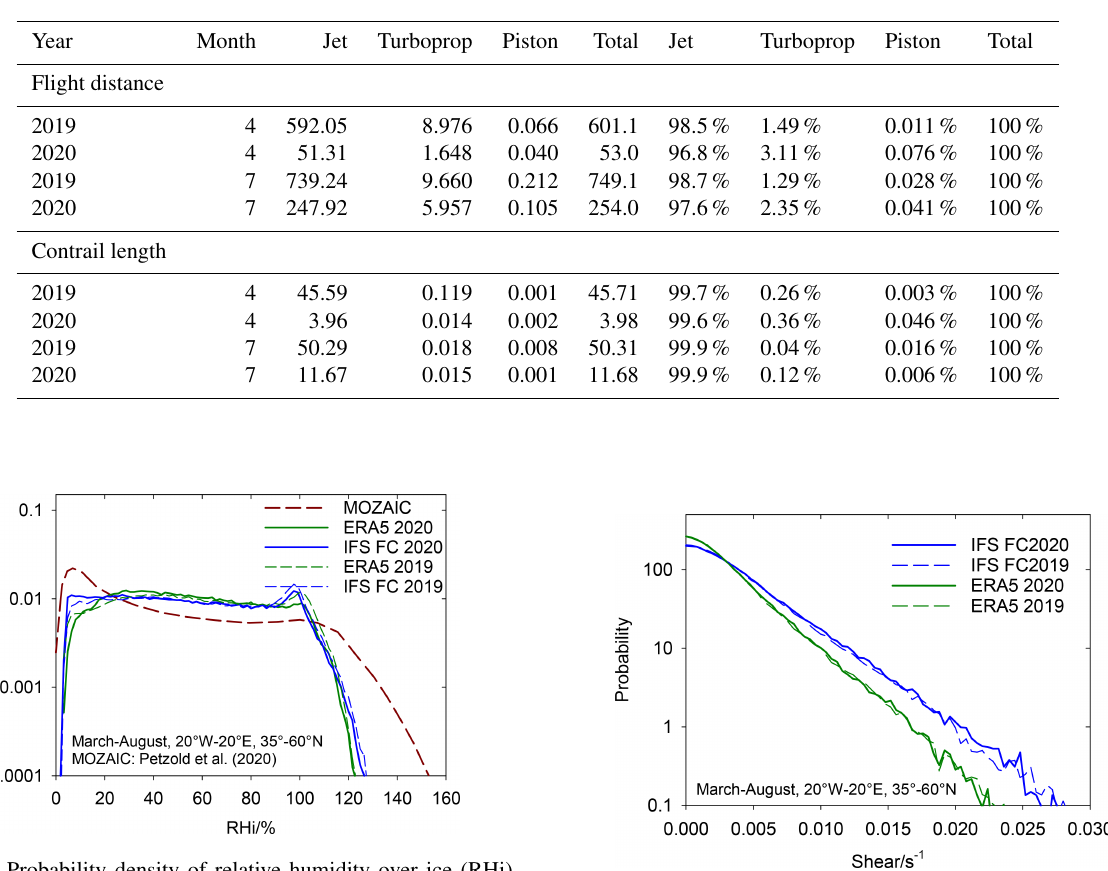
Table 2. Total flight air distances and flight air distances with persistent contrails (in Gm) of jet, turboprop, and piston-engine aircraft over Europe above FL 180 in the months of April and July in 2019 and 2020; absolute values and percentage fractions of monthly totals.